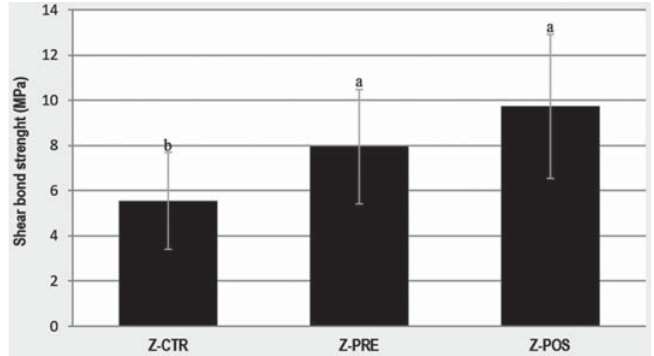
Figure 4- (cid:3)(cid:54)(cid:75)(cid:72)(cid:68)(cid:85)(cid:3)(cid:69)(cid:82)(cid:81)(cid:71)(cid:3)(cid:86)(cid:87)(cid:85)(cid:72)(cid:81)(cid:74)(cid:87)(cid:75)(cid:3)(cid:82)(cid:73)(cid:3)(cid:72)(cid:68)(cid:70)(cid:75)(cid:3)(cid:74)(cid:85)(cid:82)(cid:88)(cid:83)(cid:17)(cid:3)(cid:57)(cid:72)(cid:85)(cid:87)(cid:76)(cid:70)(cid:68)(cid:79)(cid:3)(cid:69)(cid:68)(cid:85)(cid:86)(cid:3)(cid:76)(cid:81)(cid:71)(cid:76)(cid:70)(cid:68)(cid:87)(cid:72)(cid:3)(cid:87)(cid:75)(cid:72)(cid:3)(cid:86)(cid:87)(cid:68)(cid:81)(cid:71)(cid:68)(cid:85)(cid:71)(cid:3)(cid:71)(cid:72)(cid:89)(cid:76)(cid:68)(cid:87)(cid:76)(cid:82)(cid:81)(cid:3)(cid:68)(cid:81)(cid:71)(cid:3)(cid:86)(cid:76)(cid:80)(cid:76)(cid:79)(cid:68)(cid:85)(cid:3)(cid:79)(cid:72)(cid:87)(cid:87)(cid:72)(cid:85)(cid:86)(cid:3)(cid:76)(cid:81)(cid:71)(cid:76)(cid:70)(cid:68)(cid:87)(cid:72)(cid:3)(cid:81)(cid:82)(cid:81)(cid:16)(cid:86)(cid:76)(cid:74)(cid:81)(cid:76)(cid:191)(cid:70)(cid:68)(cid:81)(cid:87)(cid:3) (cid:71)(cid:76)(cid:73)(cid:73)(cid:72)(cid:85)(cid:72)(cid:81)(cid:70)(cid:72)(cid:86)(cid:3)(cid:11)(cid:83)(cid:33)(cid:19)(cid:17)(cid:19)(cid:24)(cid:12)